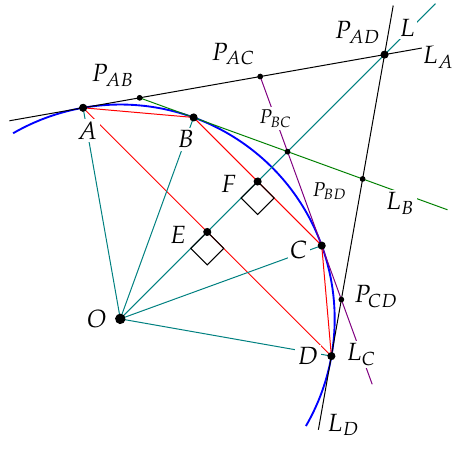
Figure 6. An isosceles trapezoid that defines a segment of a circumscribed